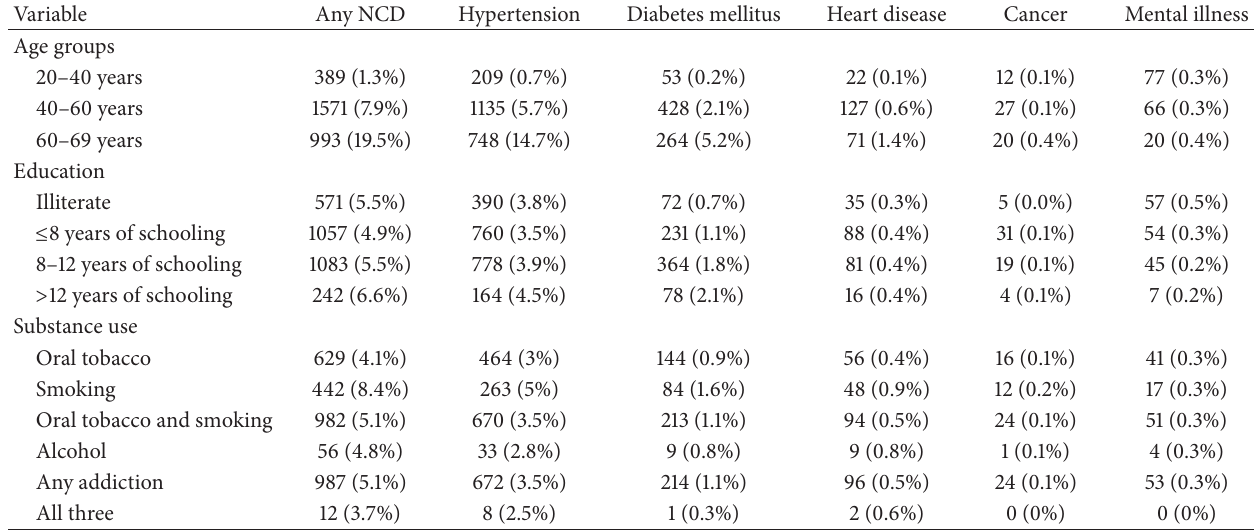
Table 4: Prevalence of self-reported noncommunicable diseases in adults (20–69 years) compared with respect to various sociodemographic